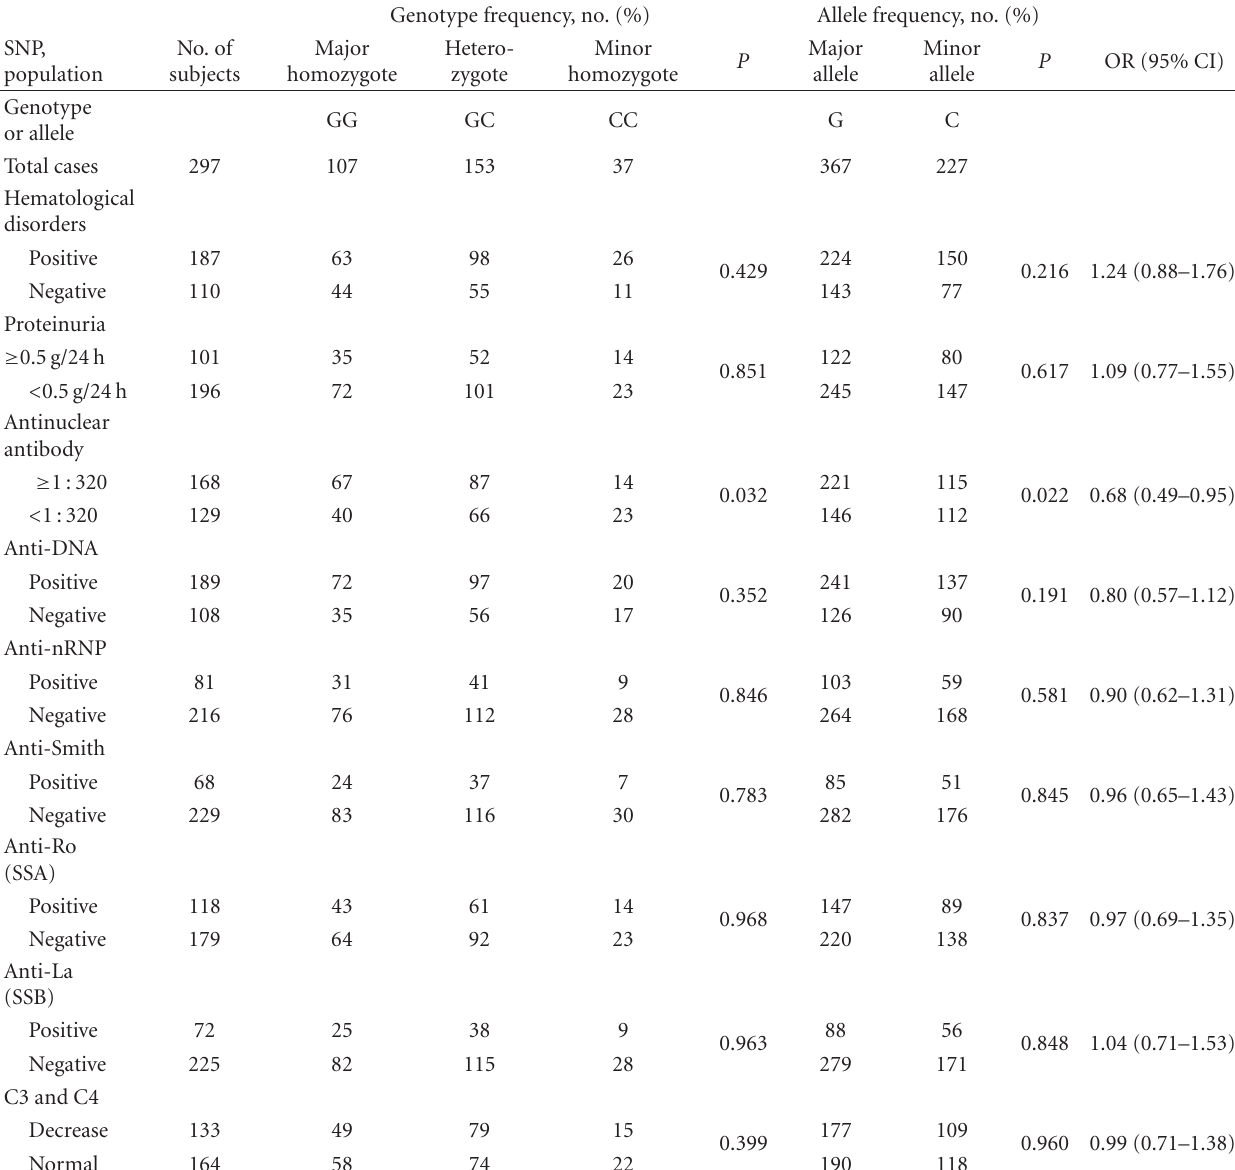
∗ SNP: single-nucleotide polymorphism; SLE: systemic lupus erythematosus; OR: odds ratios; 95% CI: 95% confidence